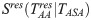
Amino acid propensity scores.(A) The propensities for surface or buried residues; Sres(TAAres|TASA). Black and gray bars denote surface and buried residues for the panel, respectively. (B) The propensities to form floating or supported segments; Sres(TAAres|Tseg). (C) The propensities to interact with polypeptides; Sres(TAAres|Tint=pep;Tseg). (D) The propensities to interact with polynucleotides; Sres(TAAres|Tint=nuc;Tseg). (E) The propensities to interact with chemical compounds; Sres(TAAres|Tint=sc;Tseg). Black and gray bars indicate floating and supported segments for the panels (B), (C), (D), and (E). Error bars are the standard deviations in 100 non-redundant datasets.